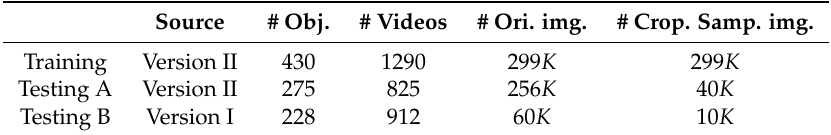
Table 3. Statistical information of the proposed Extended-Multi-Dim database. The numbers of objects, videos, originally resolved images and cropped and sampled images are shown in training and testing data sets. Source # Obj. # Videos # Ori. img. # Crop. Samp.